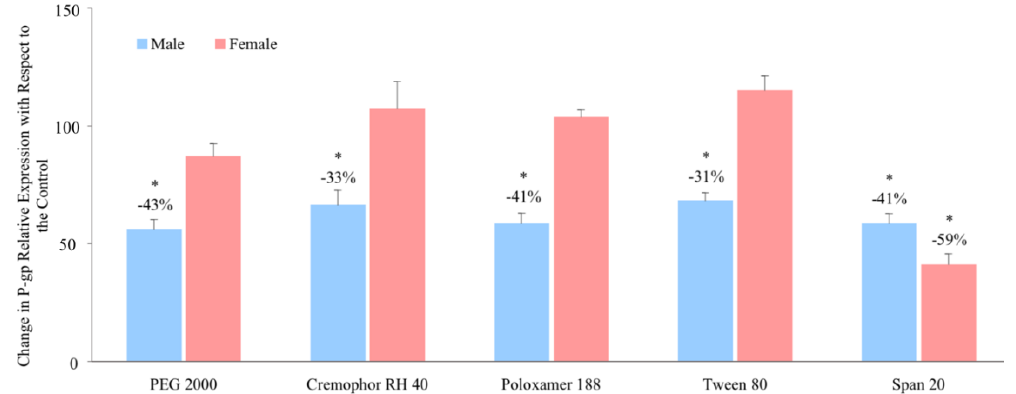
Figure 5. Percentage change in P-gp protein level in the presence of excipients in male and female Wistar rats (mean ± SD, n = 6). * Values are statistically different between the control (i.e, no excipient) and the excipient groups at p < 0.05.